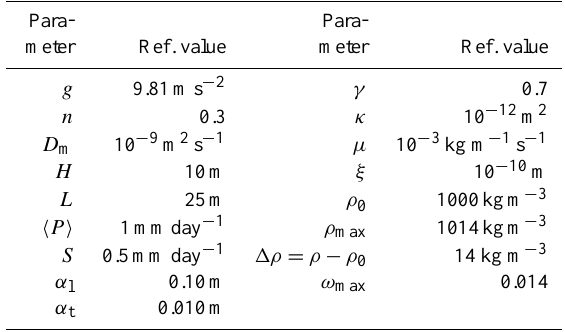
Table 1. Reference values of model parameters.